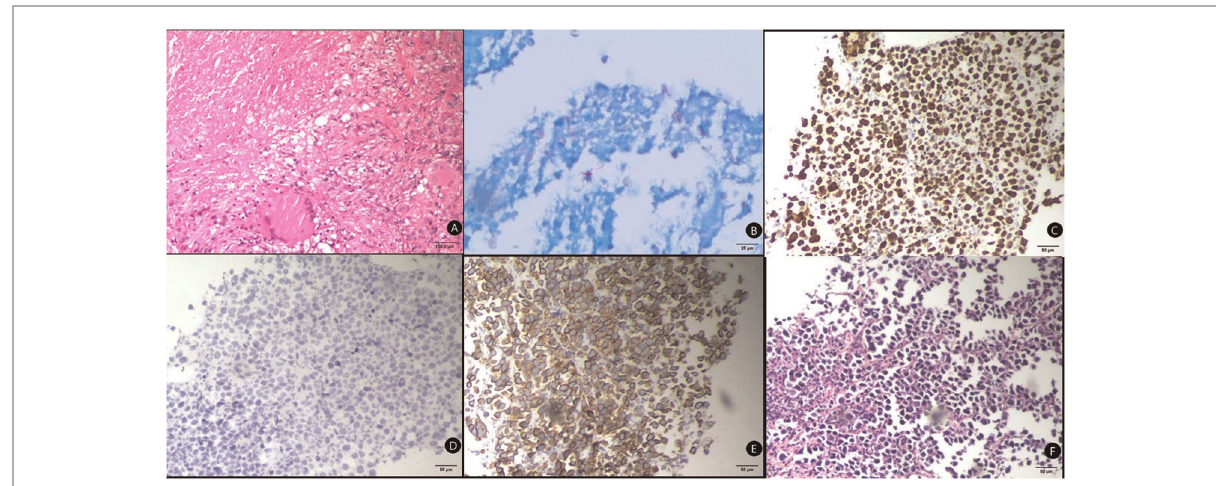
FIGURE 3 Pathological tissue examination of core needle biopsy specimens. ( A ) HE Staining of the puncture tissue, bar=100 μ m; ( B ) acid-fast staining of the puncture tissue, bar=25 μ m; ( C ) Ki67 Staining of the puncture tissue, bar=50 μ m; ( D ) CgA Staining of the puncture tissue, bar=50 μ m; ( E ) CK7 Staining of the puncture tissue, bar=50 μ m; ( F ) TTF-1 Staining of the puncture tissue, bar=50 μ